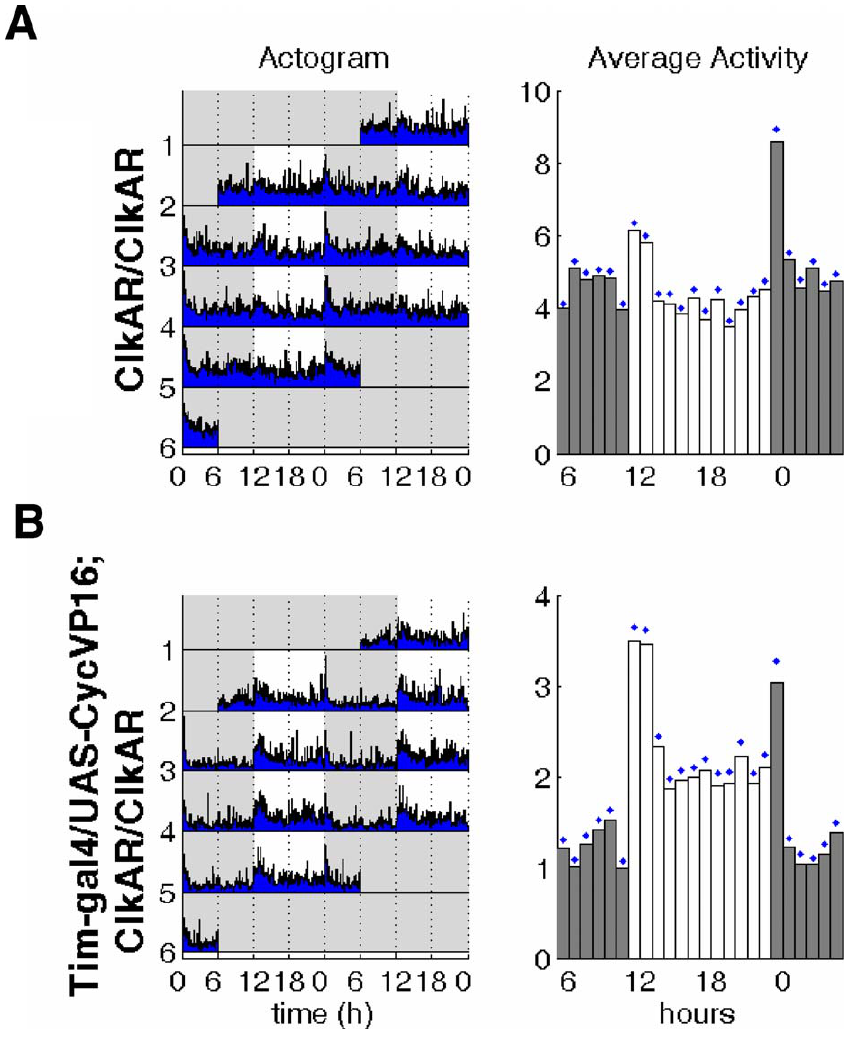
Figure 6. Expression of cyc - vp16 Partially Rescues LD Behavior in ClkAR Flies (A) Locomotor behavior of ClkAR mutant flies in LD conditions. Four standard days are shown, with timing indicated by alternating white and gray background areas with white representing the illuminated interval of LD (ZT0-12) and gray representing the dark period (ZT12-24). The behavior is shown in actograms (left) and averaged actograms (right). (B) Same as in (A), but using tim - gal4 / uas - cyc - vp16 ; ClkAR / ClkAR